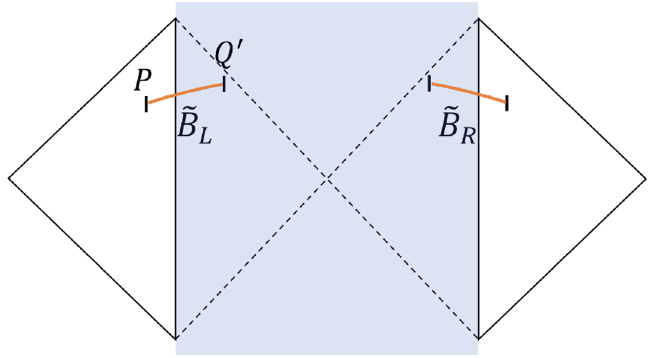
Figure 19 . ˜ B L and ˜ B R are two disjoint intervals in the presence of an island.